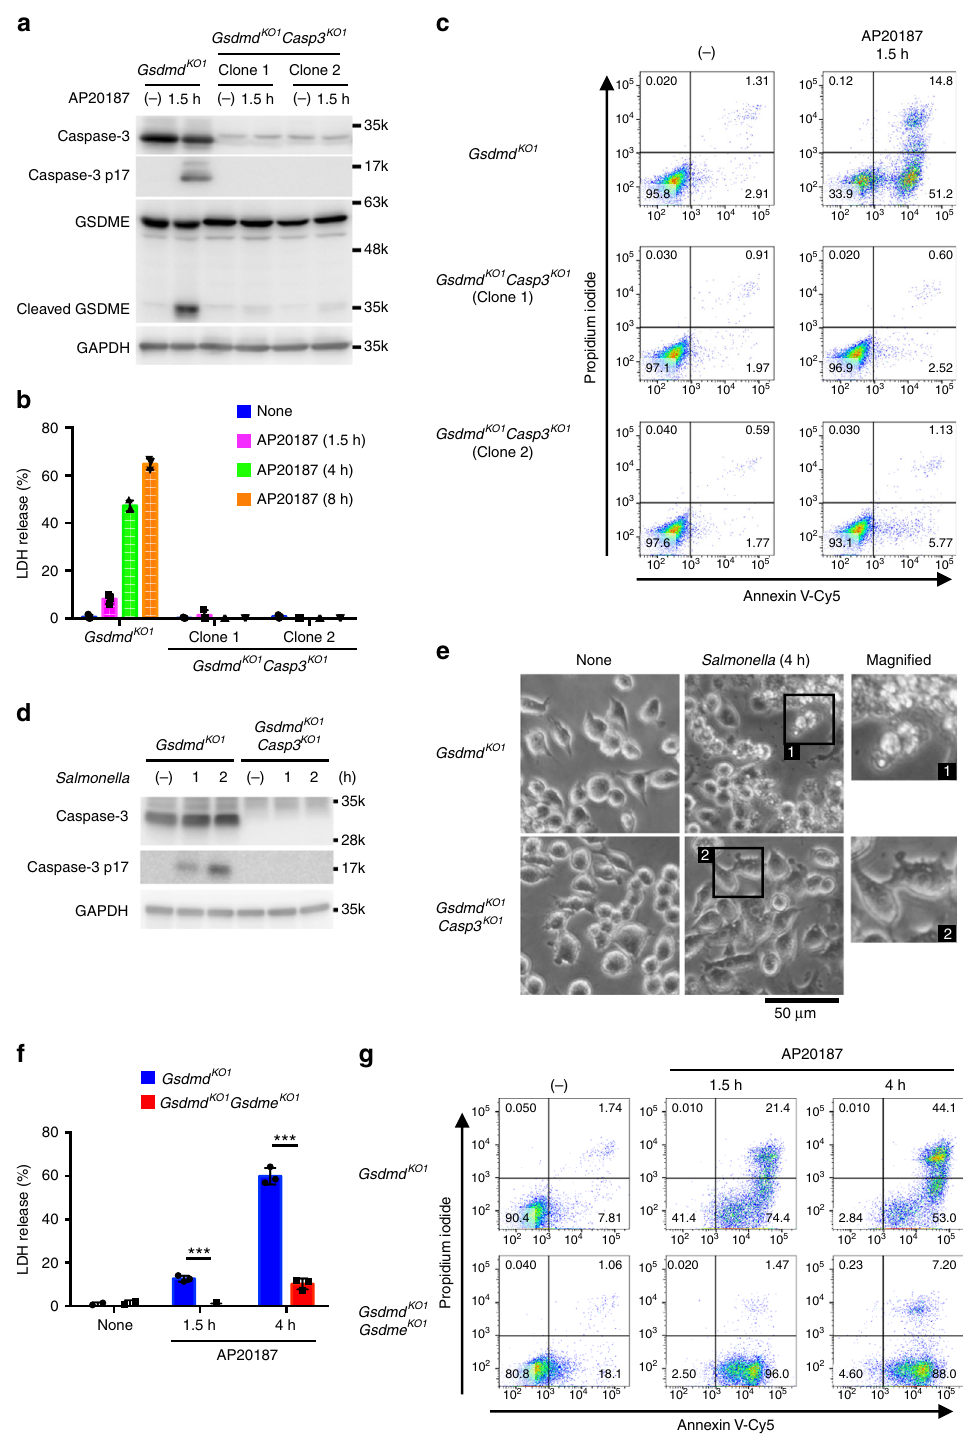
Fig. 3 Caspase-1-induced apoptosis depends on caspase-3. a – c Gsdmd -KO and Gsdmd / Casp3 -DKO CL26-iCasp1 cells were treated with AP20187 for the indicated times. Western blot detection of caspase-3 and GSDME in cell lysates ( a ). LDH release from the AP20187-treated cells ( b ). PI uptake and PS exposure analyzed by fl ow cytometry ( c ). Percentages of Annexin V + cells are shown in Supplementary Fig. 4b. d , e Gsdmd -KO and Gsdmd / Casp3 -DKO RAW264.7 cells were infected with S . Typhimurium as in Fig. 1f ( d ) or Fig. 1e ( e ). Caspase-3 in cell lysates detected by Western blotting ( d ). Microscopic images ( e ). f , g Gsdmd -KO and Gsdmd / Gsdme -DKO CL26-iCasp1 cells were treated with AP20187, and cell death was monitored by LDH release ( f ) and fl ow cytometry ( g ). Percentages of Annexin V + PI + cells and Annexin V + PI − cells are shown in Supplementary Fig. 5d. In b and f , graphs depict the mean ± SD of triplicate cultures, and individual data values are plotted ( b , f ). Statistical signi fi cance was determined using an unpaired Student ’ s t -test ( f ). *** p < 0.001. Data are from one representative of three independent experiments with similar results ( a – g ). Source data are provided as a Source Data fi le. (See also Supplementary Figs. 4 and